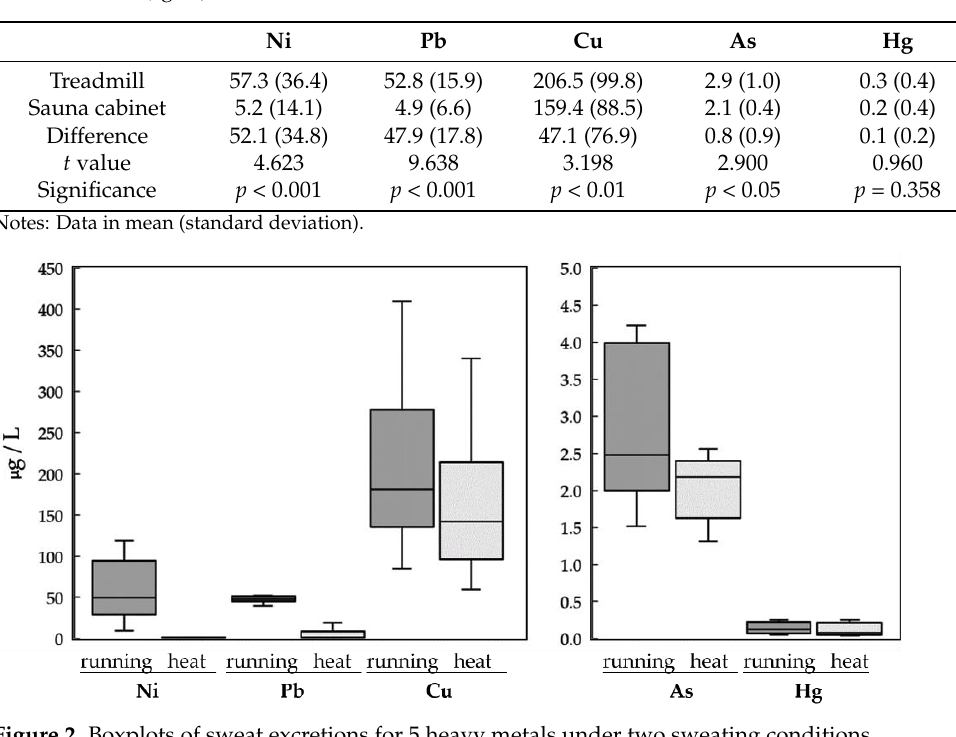
Figure 2. Boxplots of sweat excretions for 5 heavy metals under two sweating